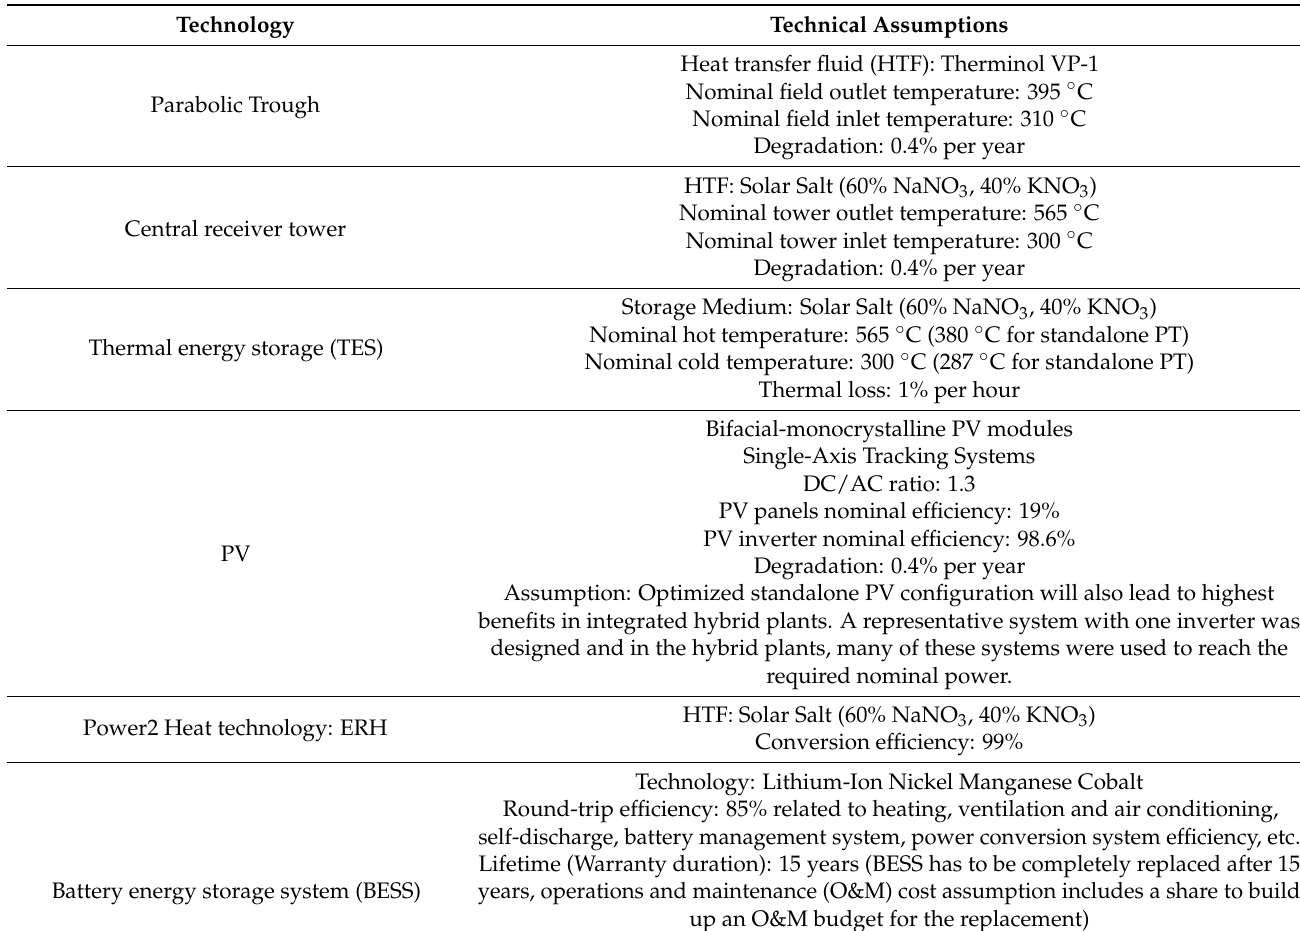
Table 1. Technical